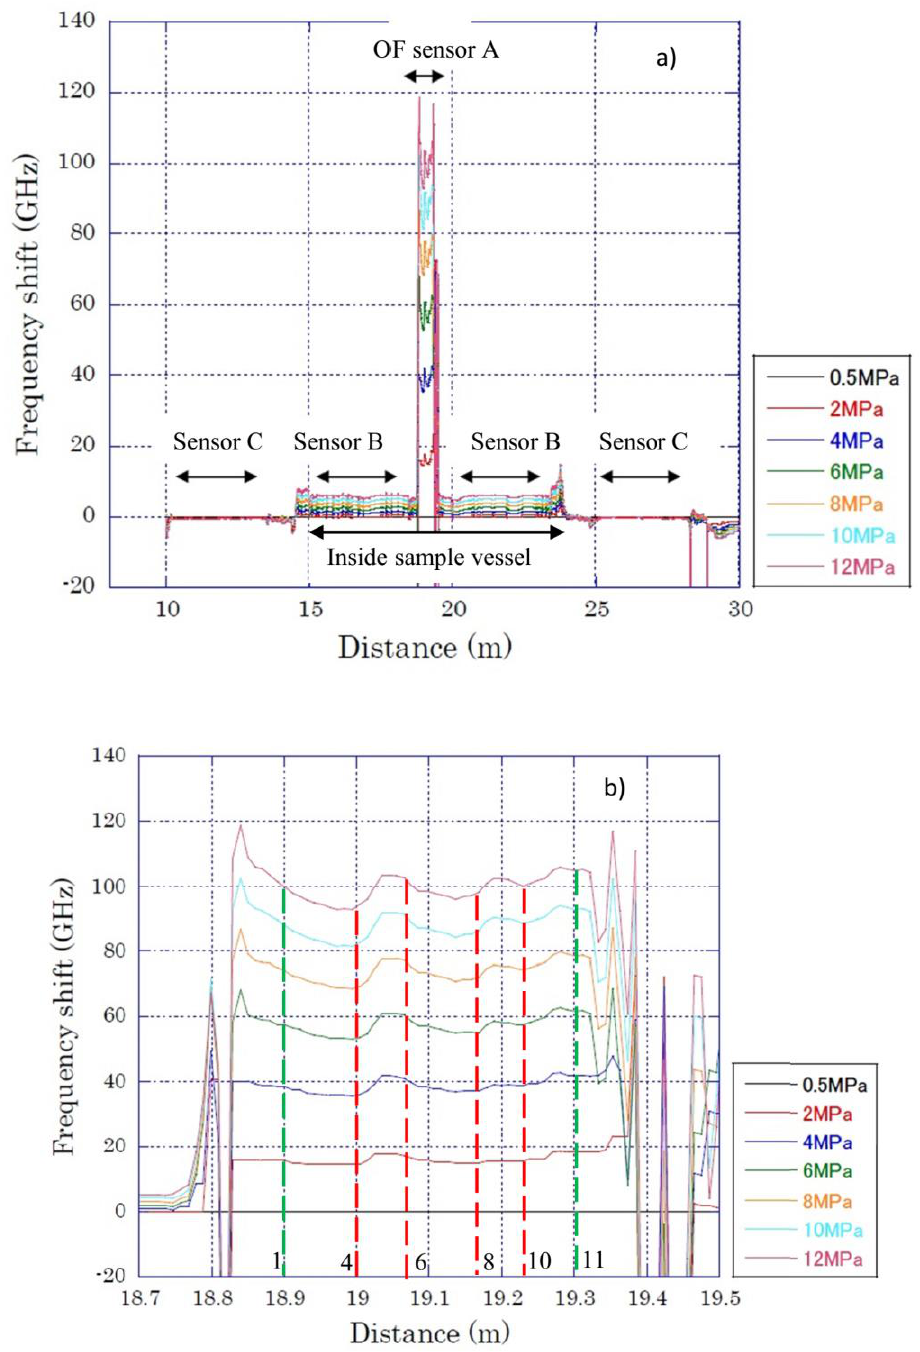
Figure 5. ( a ) Rayleigh frequency shift measurements at different confining pressures: across the all three sensor regions; ( b ) close-up in the sensor region A (Berea core). The locations of a few selected monitoring points are marked.